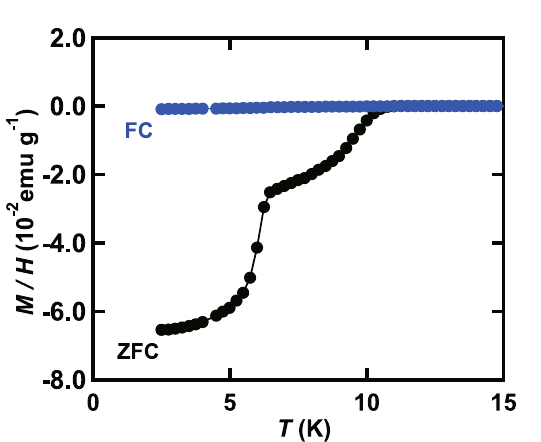
Figure 7. M / H – T plots in ZFC and FC modes for Ca 0.8 Yb 0.2 C y . Presence of two phases of CaC 6 and YbC 6 is